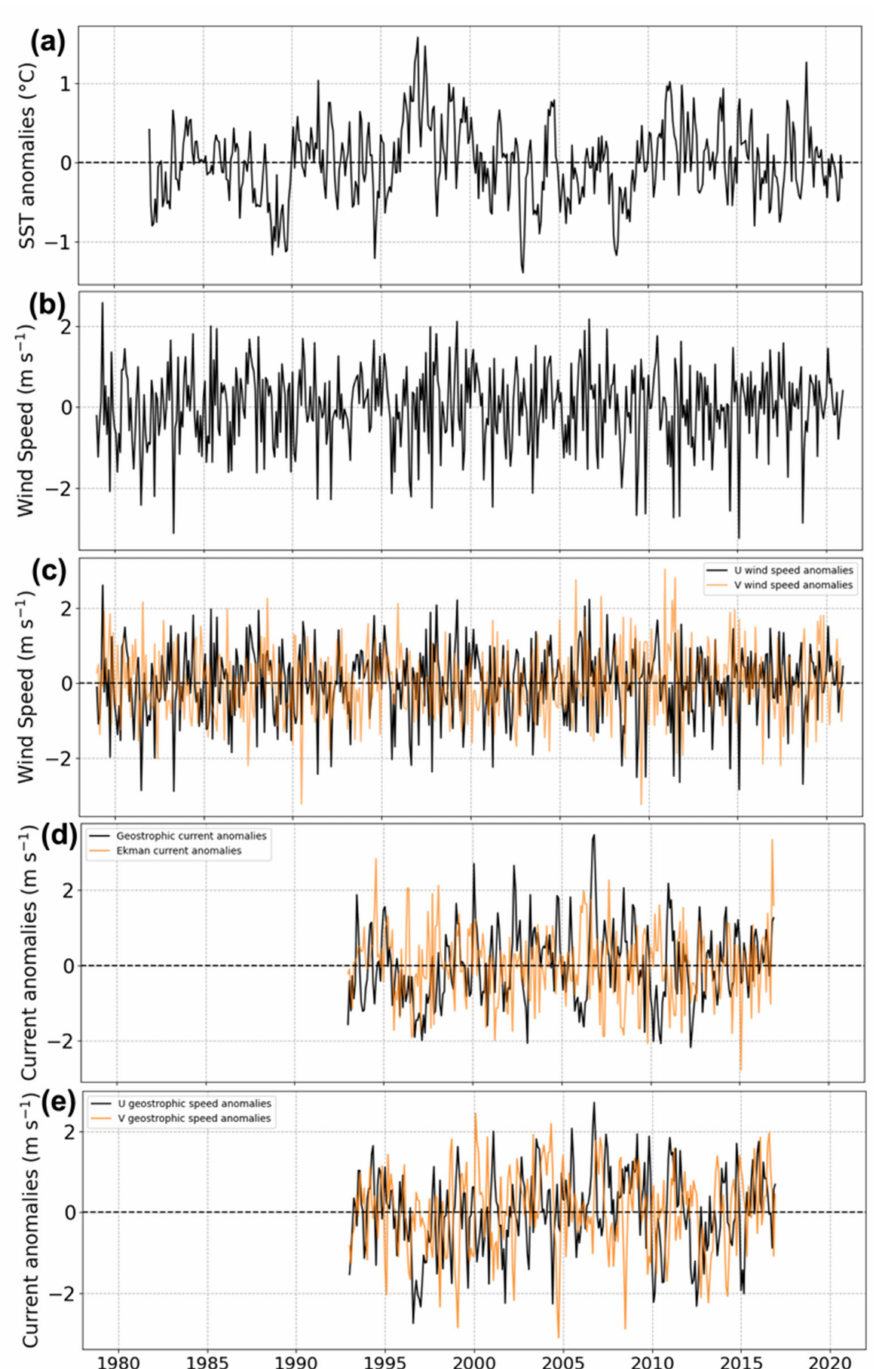
Figure 5. Time series of the standardized monthly anomalies of ( a ) Sea Surface Temperature (SST), ( b ) Wind speed, ( c ) Zonal (in black) and meridional (in orange) wind speed components, ( d ) Geostrophic (in black) and Ekman (in orange) current speeds, and ( e ) Zonal (in black) and meridional (in orange) geostrophic current speed